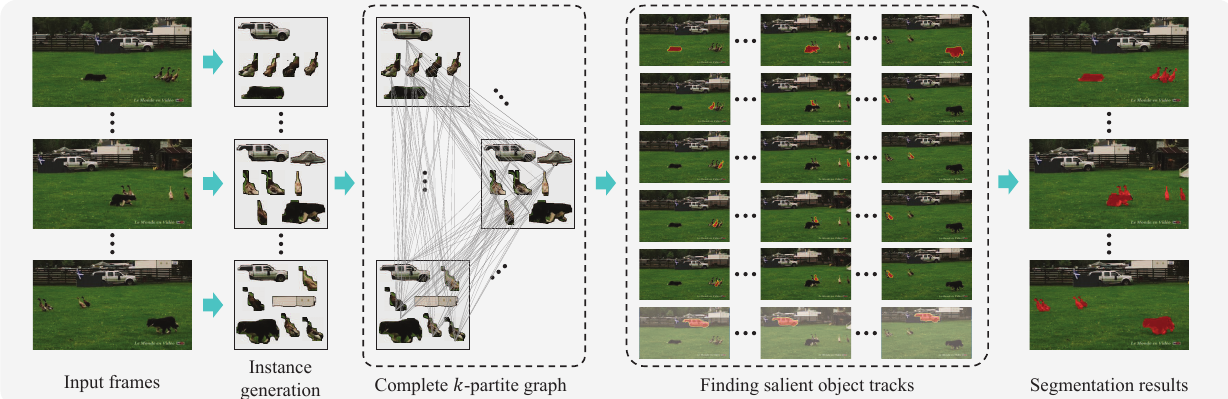
Figure 1. An overview of the proposed